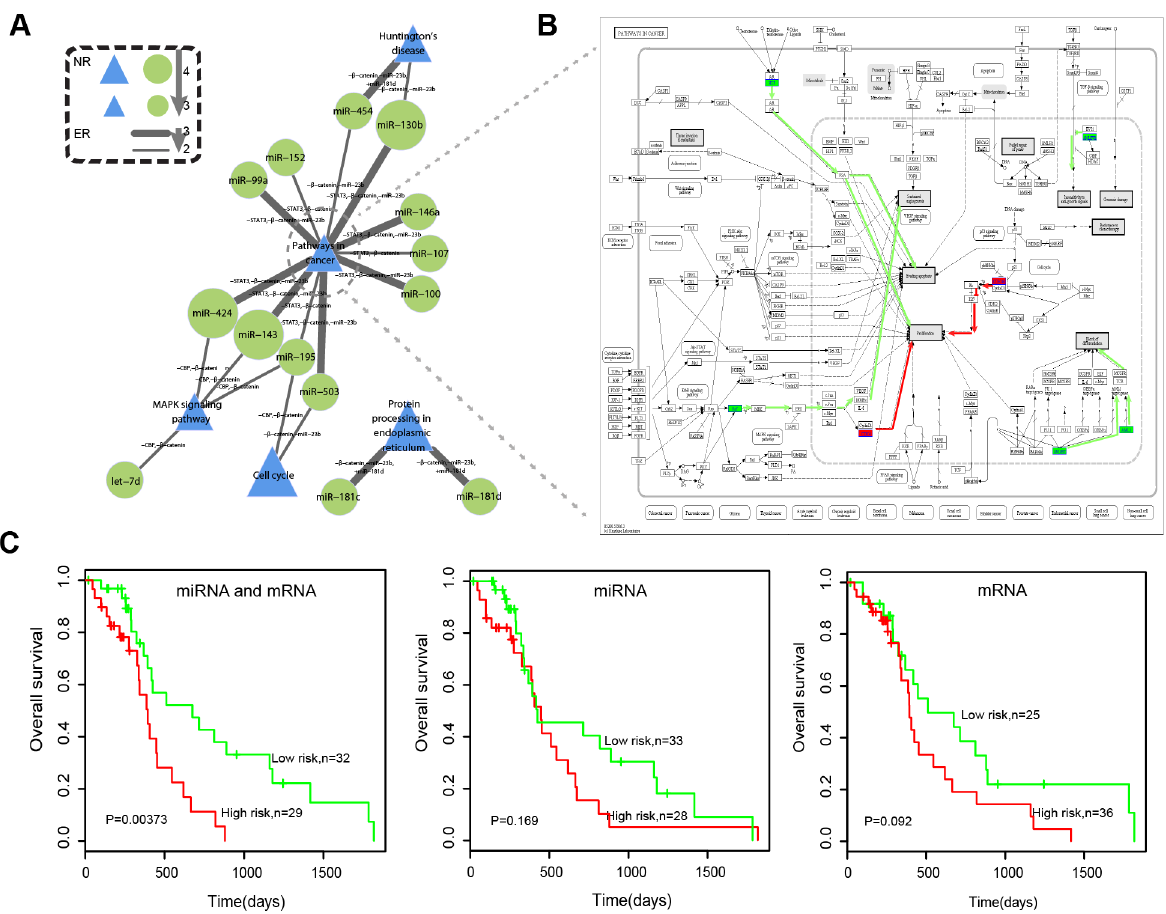
Figure 6. Association between the core module of cMPRN and glioma patient survival. (A) Green circles and blue triangles represent functional miRNAs and target pathways, respectively, in the core module. (B) Distribution of genes differentially expressed in the same direction under the three conditions sharing pathways in cancer: 2 STAT3, 2 b -catenin, and –miR-23b. Red and green rectangles represented genes that are up- and downregulated by the three experimental manipulations, while the white ones represent other genes within pathways in cancer. Red and green lines represent signal transduction downstream of these up- and downregulated genes, respectively. (C) Kaplan-Meier survival plot of the two subgroups of glioblastoma patients sorted by k-means clustering based on expression levels of either miRNA or mRNA signatures or both in the core module.